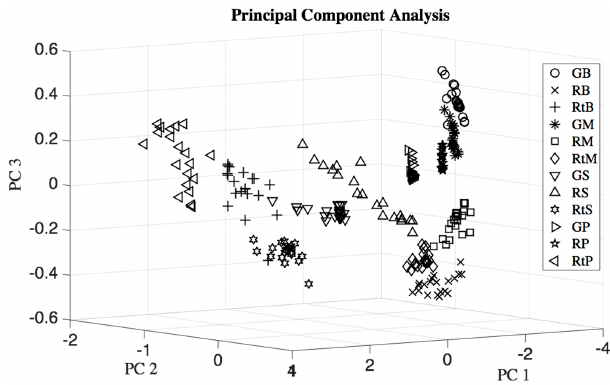
Figure 7. Time versus voltage responses of eight sensors to rotten sapodilla. S1 to S8 are sensor labels as listed in Table 1. A three dimensional PCA scores plot of banana, mango, sapodilla, and pineapple at three ripeness states in Figure 8 shows that few samples of green banana and green mango, ripe mango and rotten mango, rotten banana and green sapodilla, rotten banana and rotten sapodilla overlapped with each other.